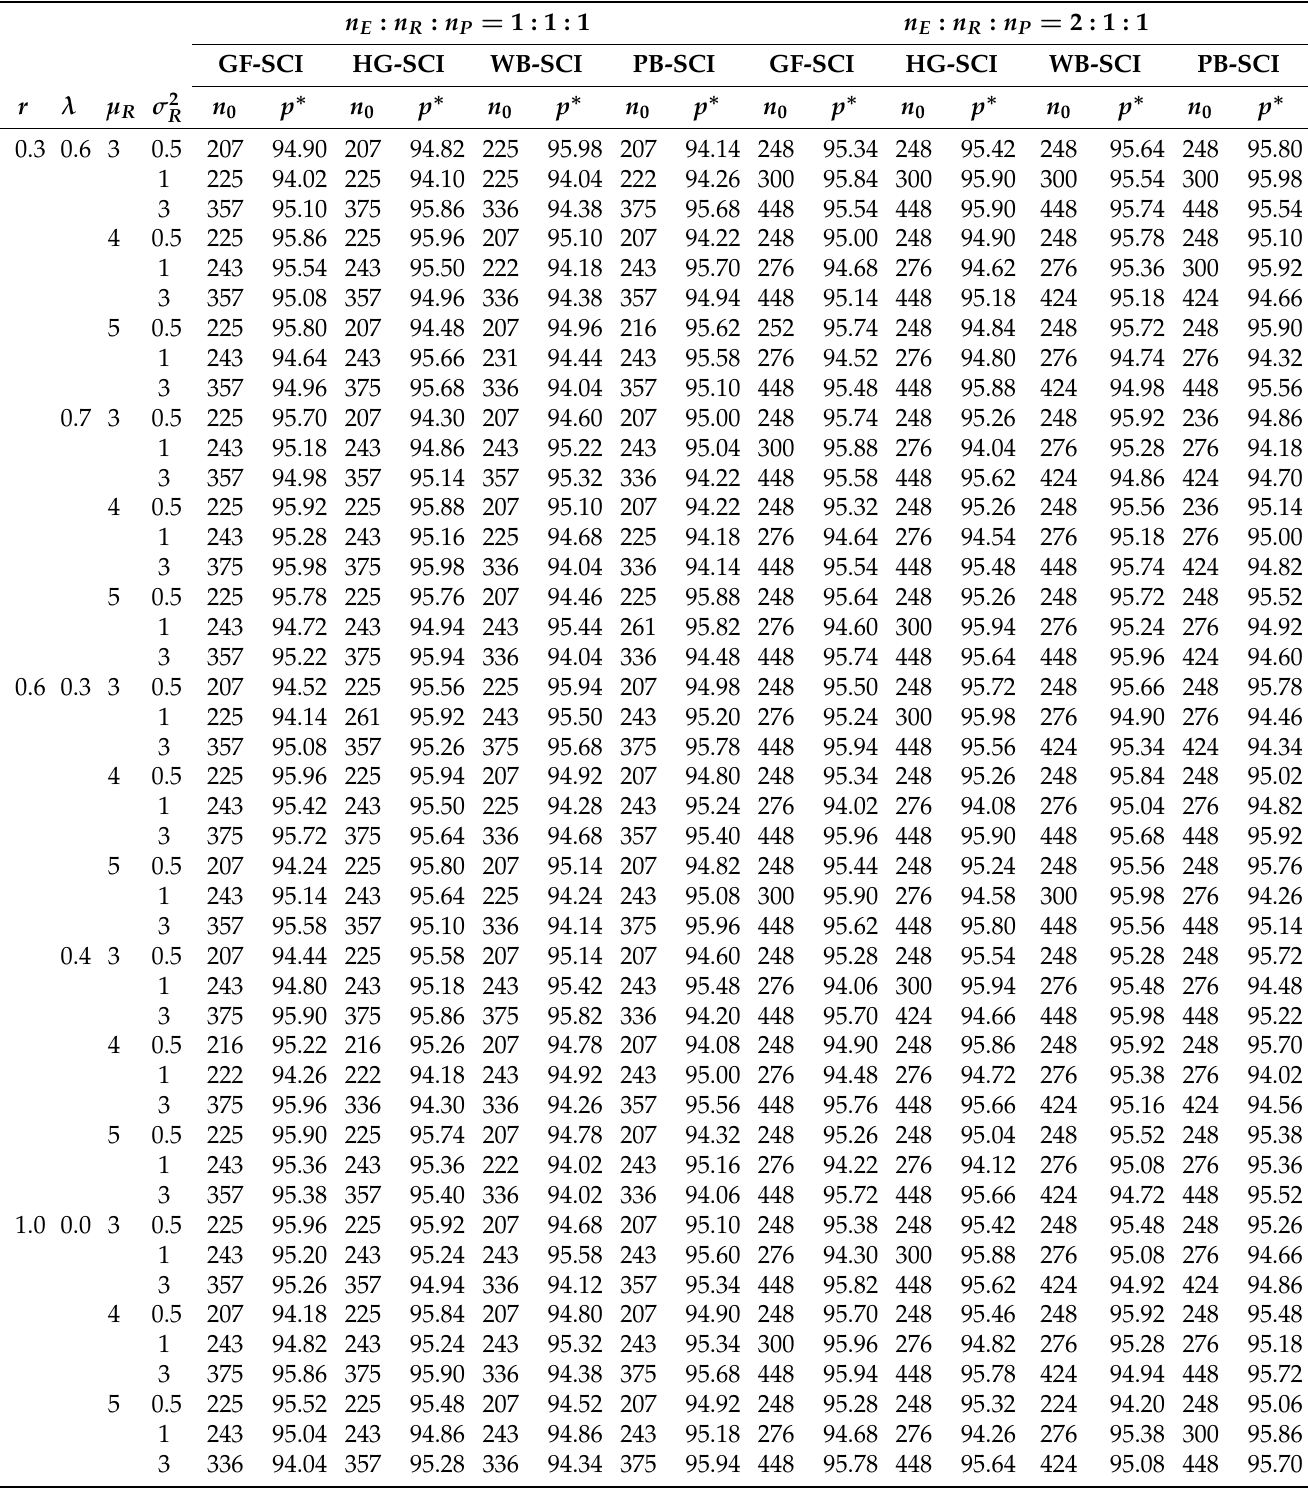
Table 5. The required sample sizes n for true power 1 − β = 95% and its empirical powers p ∗ under various settings with (cid:101) =